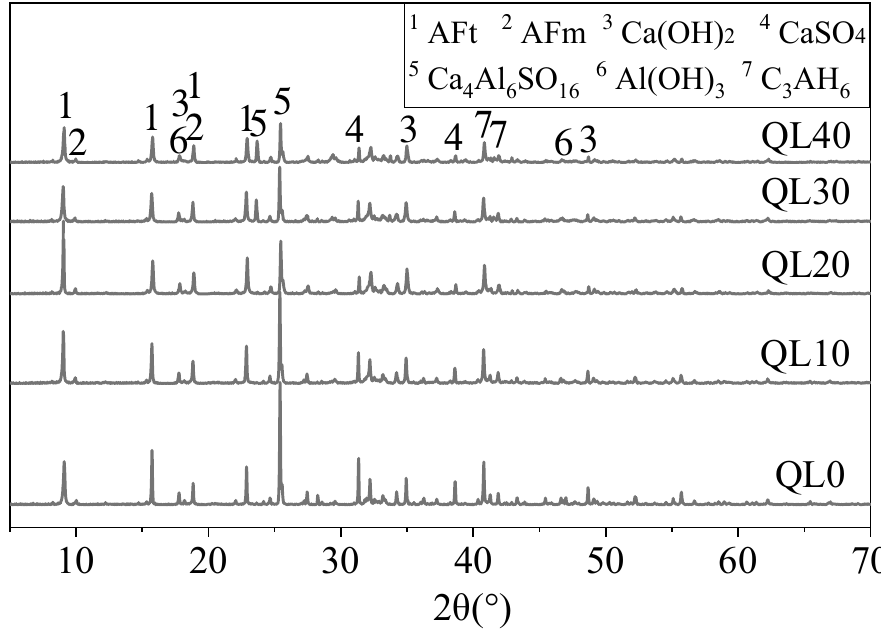
Figure 11. XRD patterns of the double liquid grouting materials with different quicklime content at 1 day. Materials 2019 , 12 , x FOR PEER REVIEW